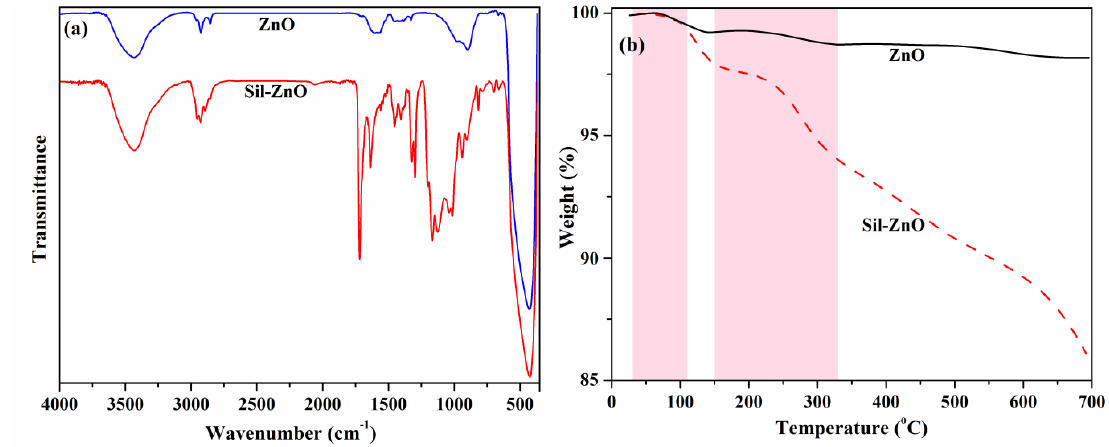
Figure 3. Fourier transform infrared (FTIR) spectra ( a ) and thermogravimetric analysis (TGA)thermograms ( b ) of ZnO and Sil-ZnO nanoparticles.